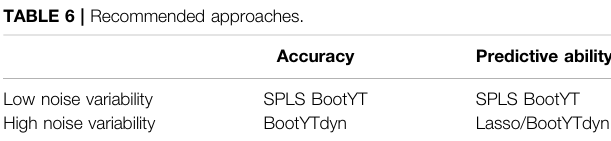
TABLE 6 | Recommended